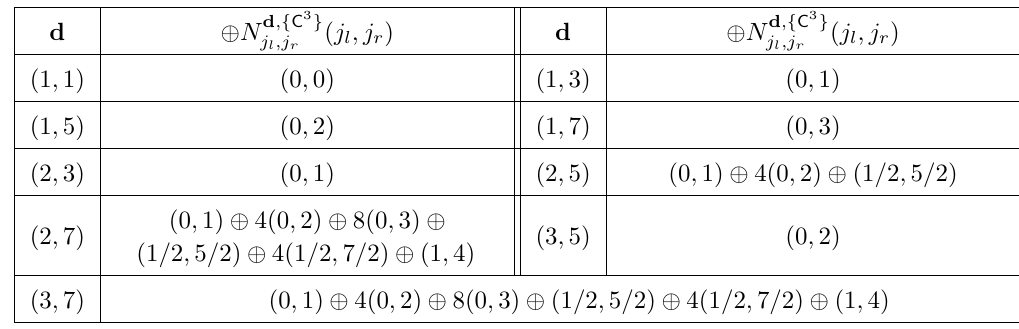
for the curve class d 1 m 0 + d 2 φ with d 1 ≤ 3 BPS , { C 3 }